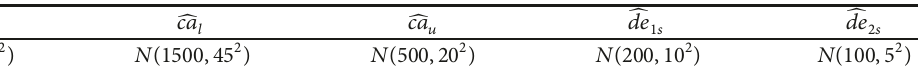
Table 6: Probability distribution of capacity/demand (ton).